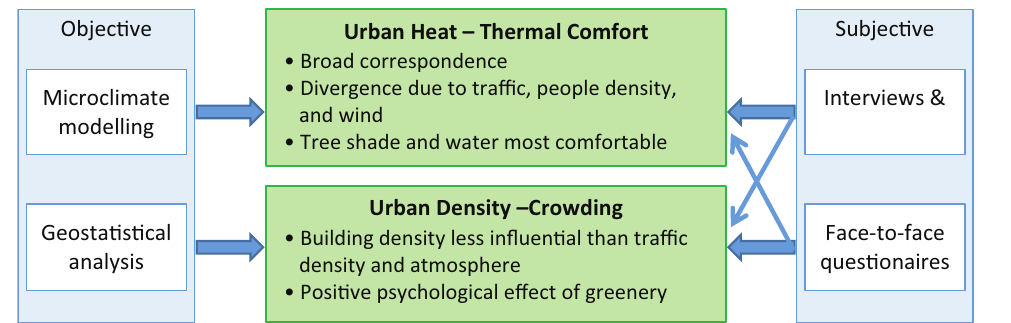
Figure 7. Summary of interaction and main results of the mixed‐methods